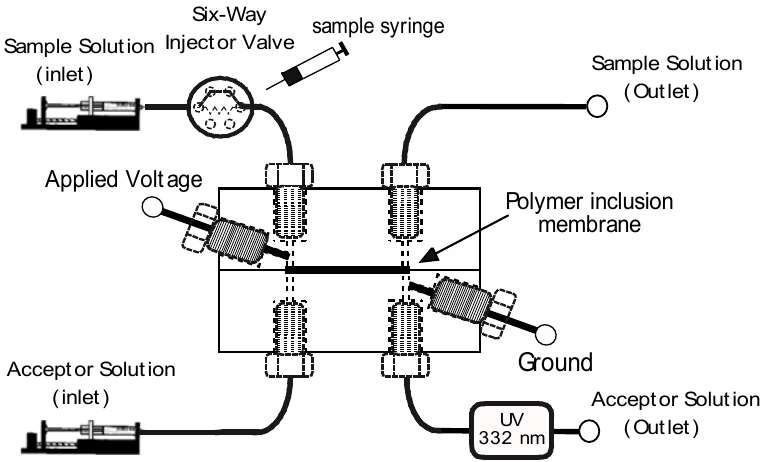
Figure 1. Schematic drawing of the electromembrane extraction (EME)-cell and the associated manifold including the UV-absorption detector. Not drawn to scale. Table 1. Typical operating